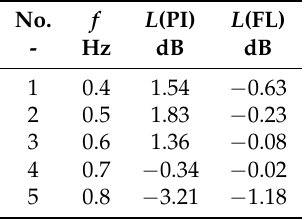
Table 3. Table of the measured parameters of the progressive sinusoidal waves generated with the fuzzy-logic FL versus proportional-integral PI control algorithms. No. f L